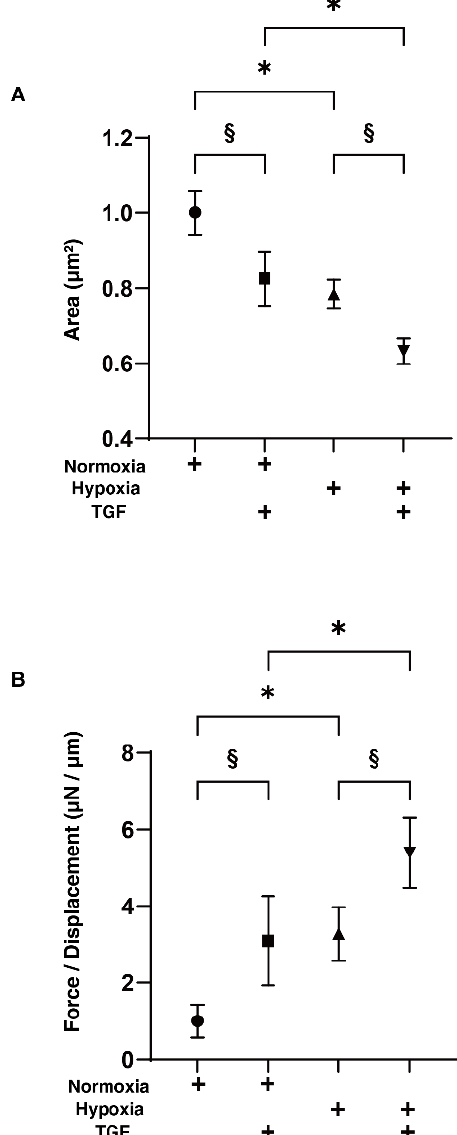
Figure 2. Effects of TGF- β 2 on the physical properties, sizes and stiffness of 3D HRPE spheroids under normoxia or hypoxia conditions. Three-dimensional HRPE spheroids at Day 6 prepared under normoxia or hypoxia conditions were treated without (control) or with a 5 ng/mL solution of TGF- β 2 (TGF). The mean sizes of 3D HRPE spheroids were measured and each relative ratio against the normoxia conditions without TGF- β 2 are plotted in panel ( A ). The physical solidity of the 3D HRPE spheroids was analyzed by a micro-squeezer and the force required to produce a 50% deformity of a single spheroid during a period of 20 s ( µ N/ µ m) was plotted in panel ( B ). All experiments were performed in triplicate using fresh preparations consisting of 16 spheroids each. “+” is reagents addition. Data are presented as the arithmetic mean ± standard error of the mean (SEM). * p < 0.05 control vs. TGF, § p < 0.05 normoxia vs. hypoxia (ANOVA followed by a Tukey’s multiple